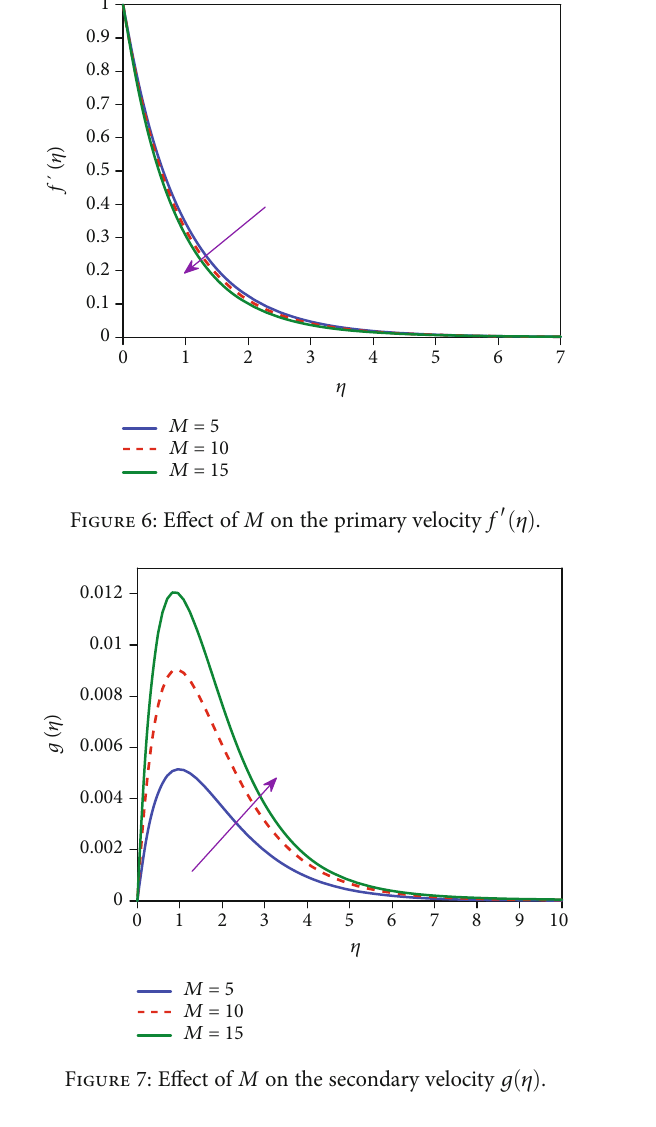
Figure 10: E ff ect of β on the primary velocity f ′ ð η Þ . e